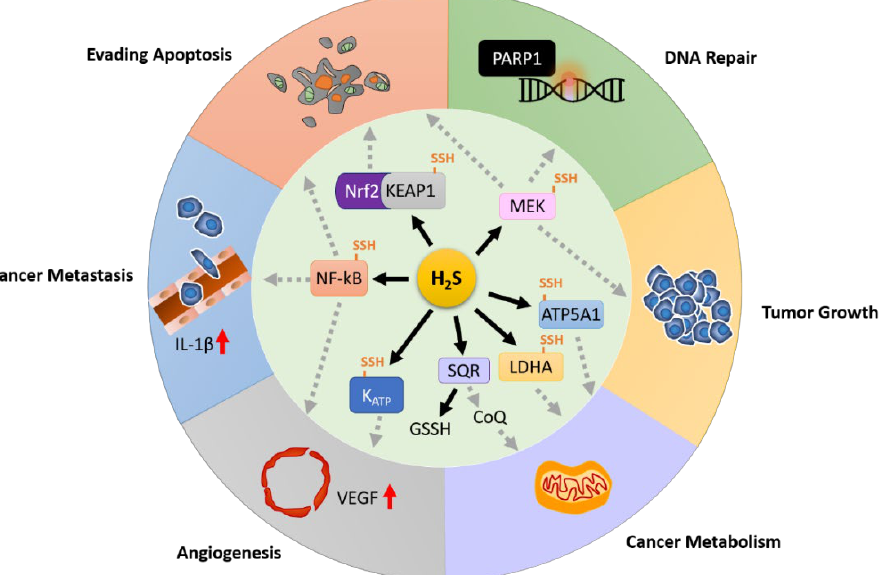
Figure 3. The potential role of H 2 S during cancer development. Illustration of the six cancer hallmarks mediated by H 2 S modulated protein persulfidation or using H 2 S as a metabolic substrate for electron transfer.